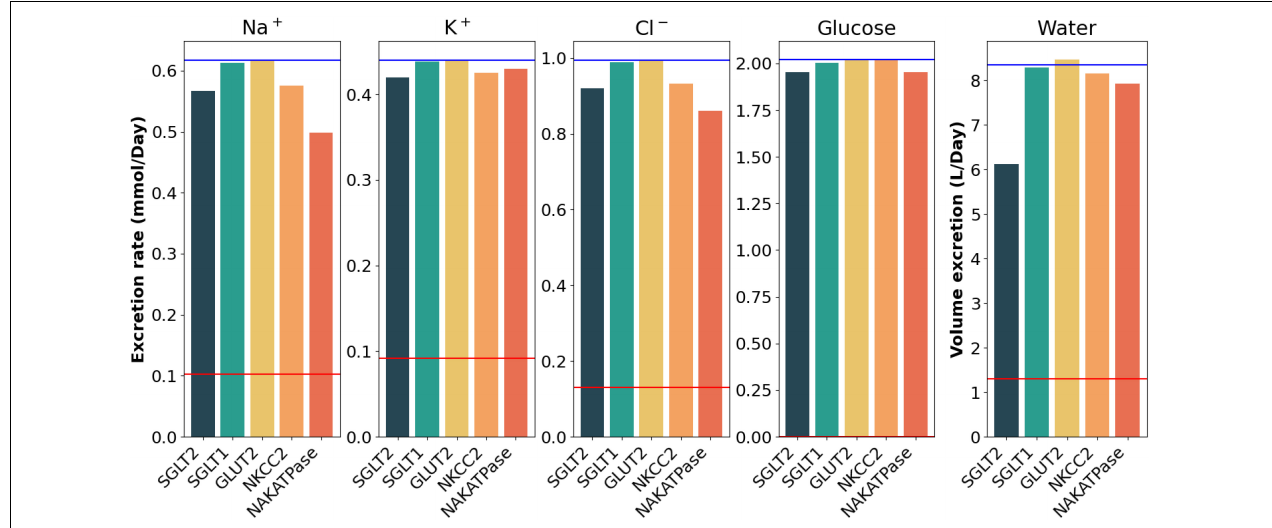
FIGURE 8 | Urinary excretion of Na + , K + , Cl – , glucose, and fluid, computed for severely diabetic men. Results are obtained with SGLT2 inhibition upon a 20% increase in the individual activity of the five specific transporters: SGLT2, SGLT1, GLUT2, NKCC2, Na + -K + -ATPase. The red lines denote the solute and volume prediction in healthy male under no drugs. The blue lines indicate the levels predicted by the model for severely diabetic males under 90% SGLT2